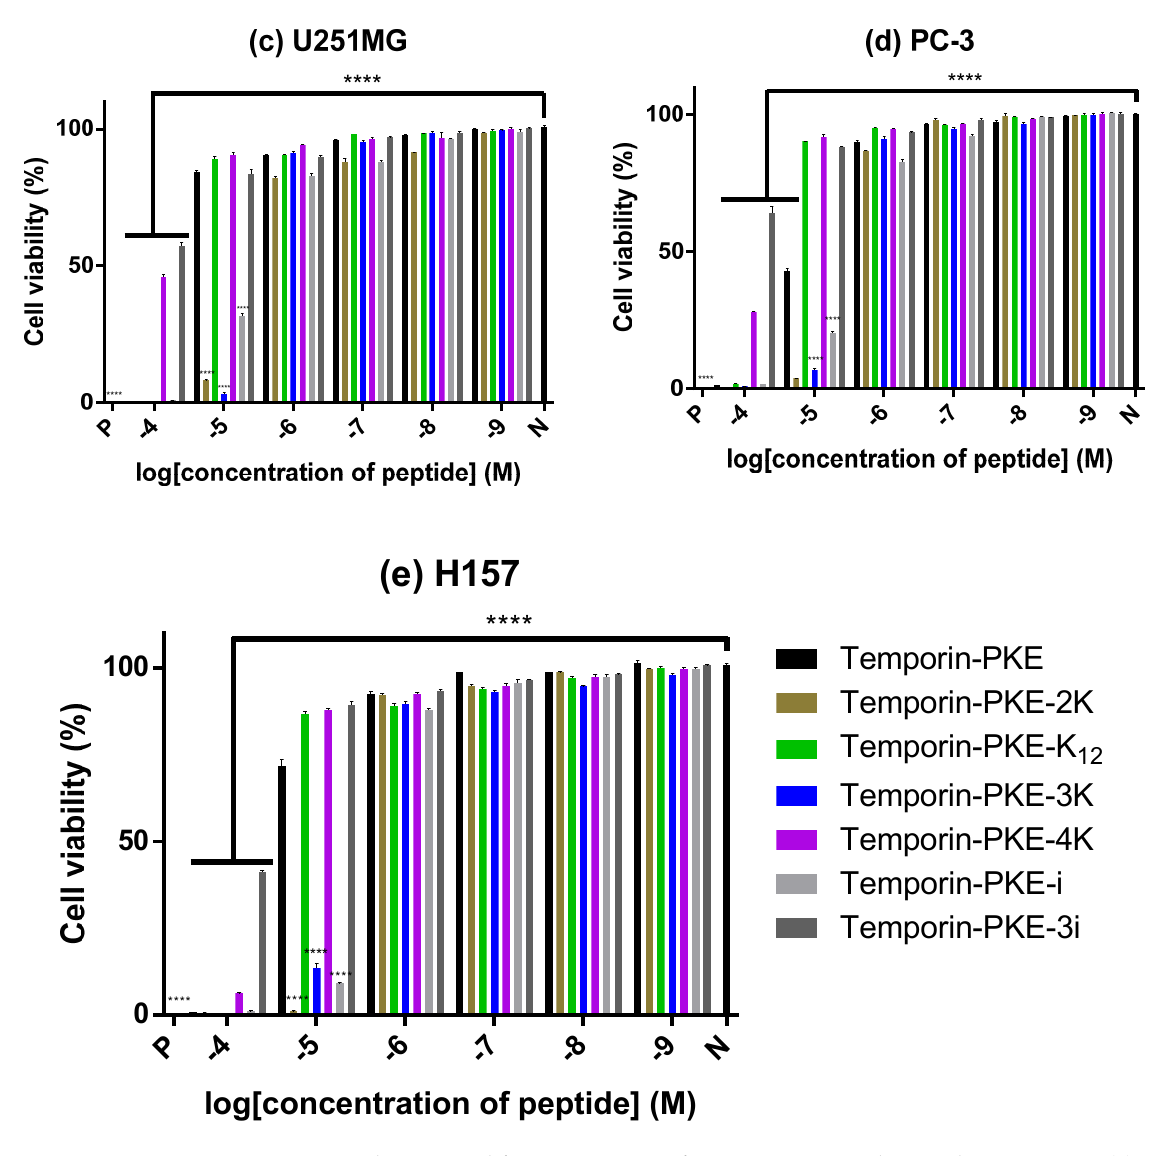
Figure 10. The anti-proliferation activity of temporin-PKE and its analogues against ( a ) HCT-116, ( b ) H838, ( c ) U251MG, ( d ) PC-3, and ( e ) H157 cells. PBS and 0.1% Triton X-100 were used as negative control and positive control, respectively. The results were analysed by two-way ANOVA and Dunnett’s multiple comparisons test, which compared different concentrations of peptides with the negative control group. The symbol **** indicates p < 0.0001. The error bar represents the SEM of the nine replicates in three tests (three replicates in each